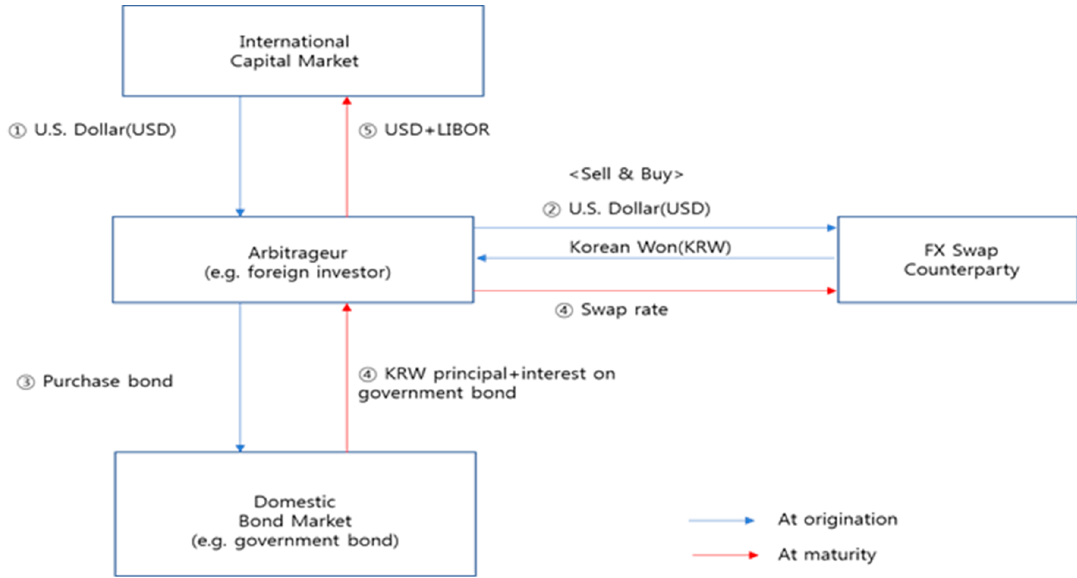
Figure 1. The transaction mechanisms in the foreign exchange related swap market.